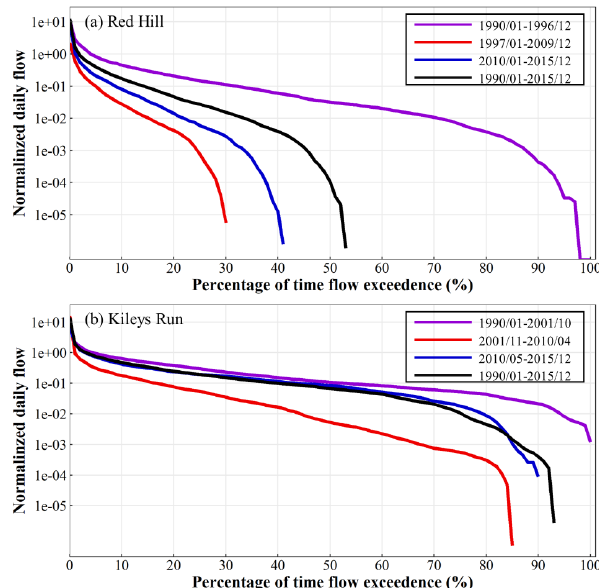
Figure 5. Daily flow duration curves of (a) the Red Hill catch- ment (treated catchment) and (b) the Kileys Run catchment (con- trol catchment), New South Wales, Australia, over three different